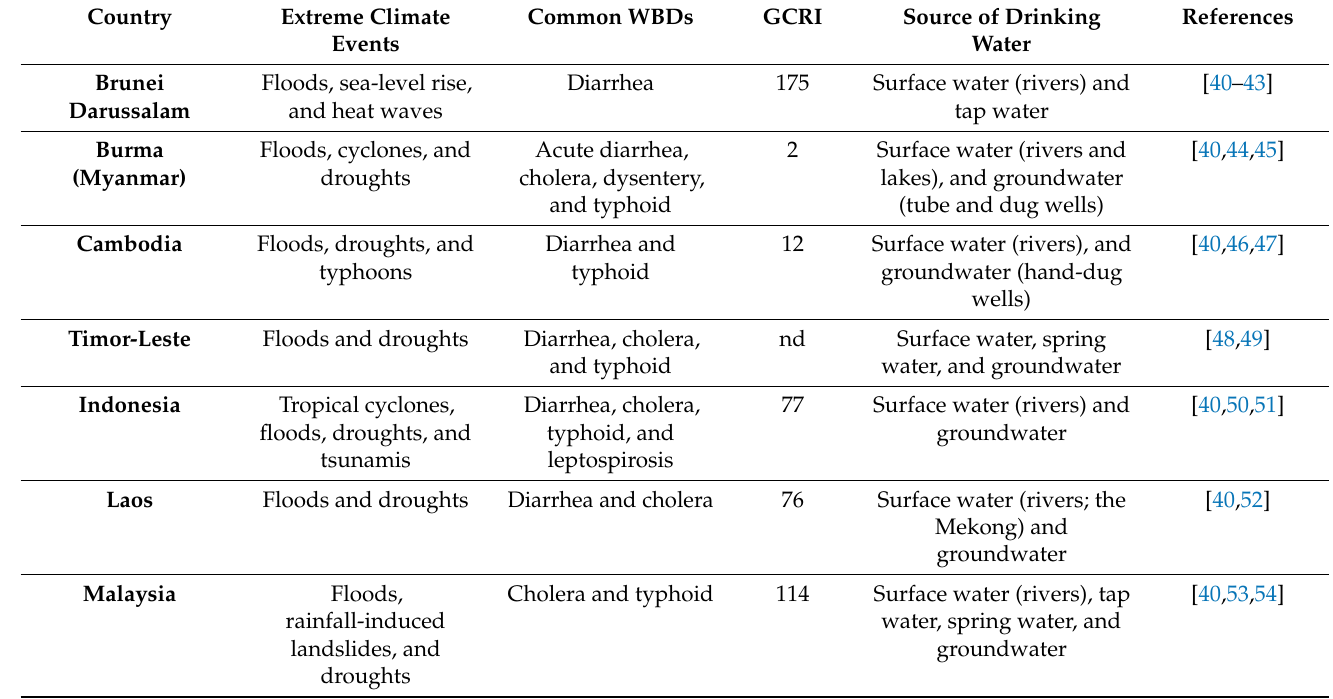
Table 1. Typical extreme climate events and common water-borne diseases (WBDs) with the Global Climate Risk Index (GCRI, 1999–2018) in the Southeast Asian